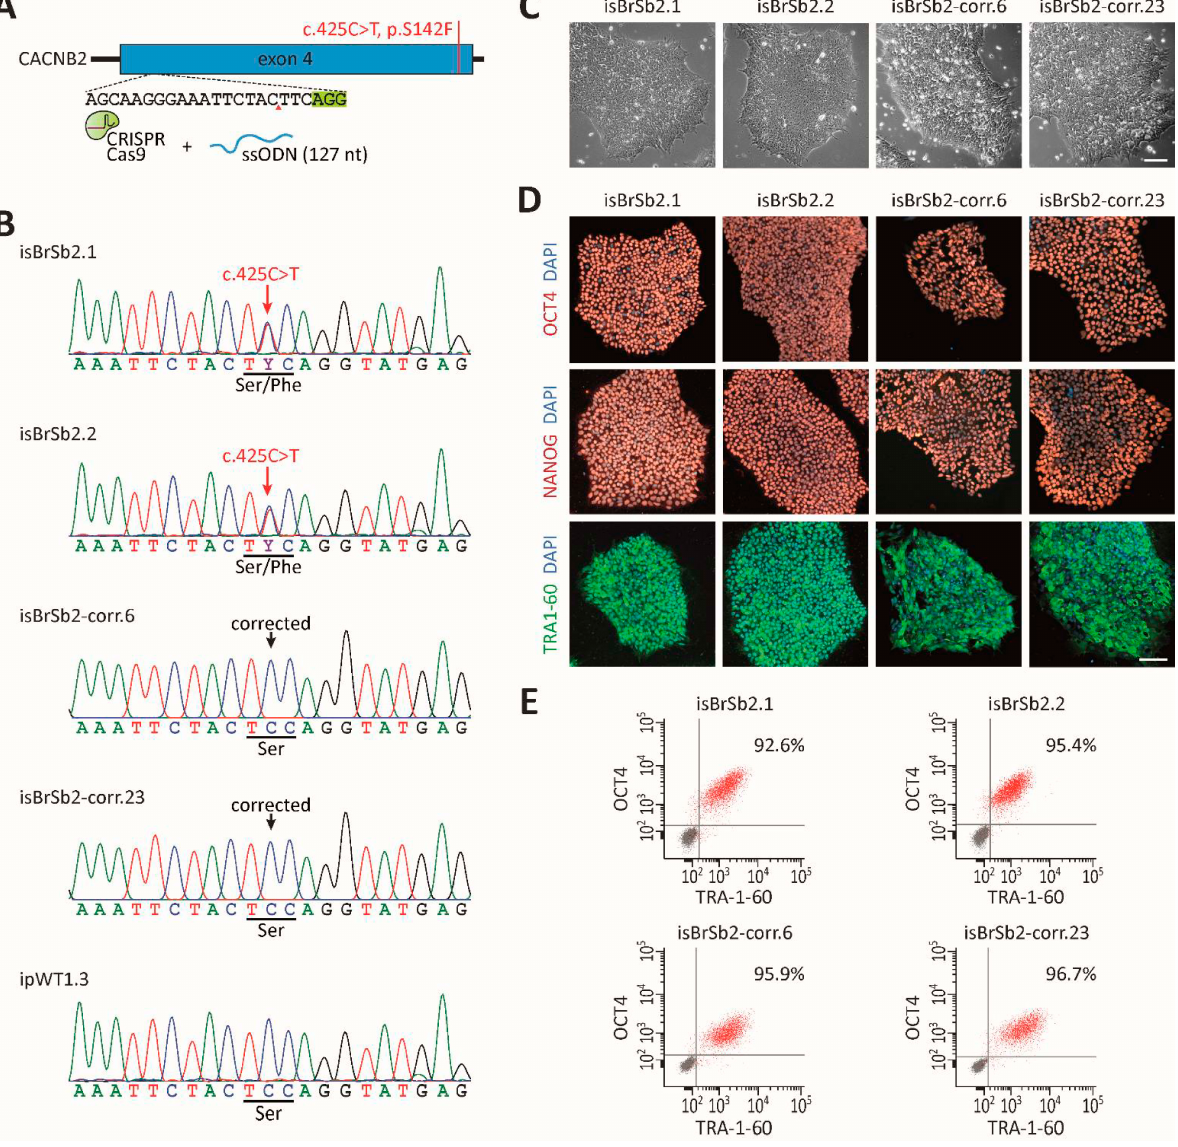
Figure 2. Genetic correction of BrS-hiPSCs by CRISPR/Cas9 genome editing. ( A ) Corrected hiPSCs were generated with a CRISPR guide RNA targeting the CACNB2 exon 4 and a single-stranded oligonucleotide (ssODN) for homology-directed repair. ( B ) Confirmation of genetic correction, assessed by Sanger sequencing of genomic DNA. ( C ) Patients’ and CRISPR-corrected hiPSC lines exhibited a typical human stem cell-like morphology. Scale bar: 100 μ m. ( D ) Immunofluorescence staining for key pluripotency markers OCT4, NANOG and TRA1–60 in patients’ and corrected hiPSC lines. Nuclei were counter-stained with DAPI. Scale bar: 100 μ m. ( E ) Purity of patient-specific and CRISPR-corrected hiPSC lines was evaluated by the flow cytometry analysis of pluripotency markers OCT4 and TRA1–60. Gray dots represent the negative controls.